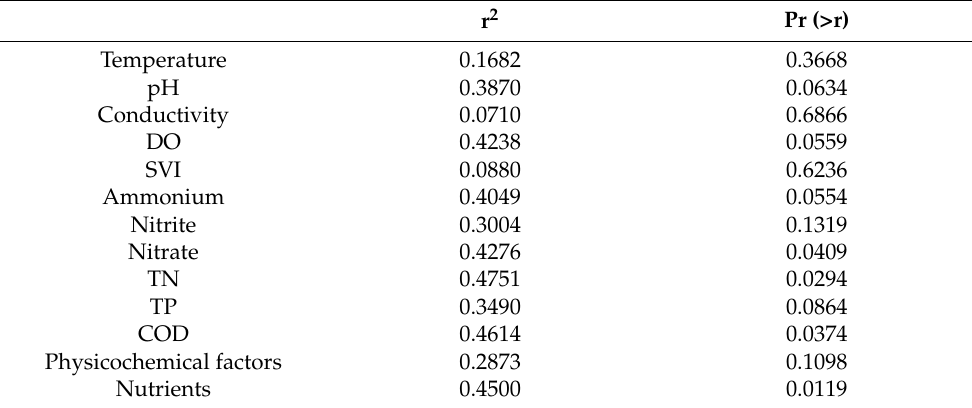
Table 4. Results of Mantel test for environmental factors.